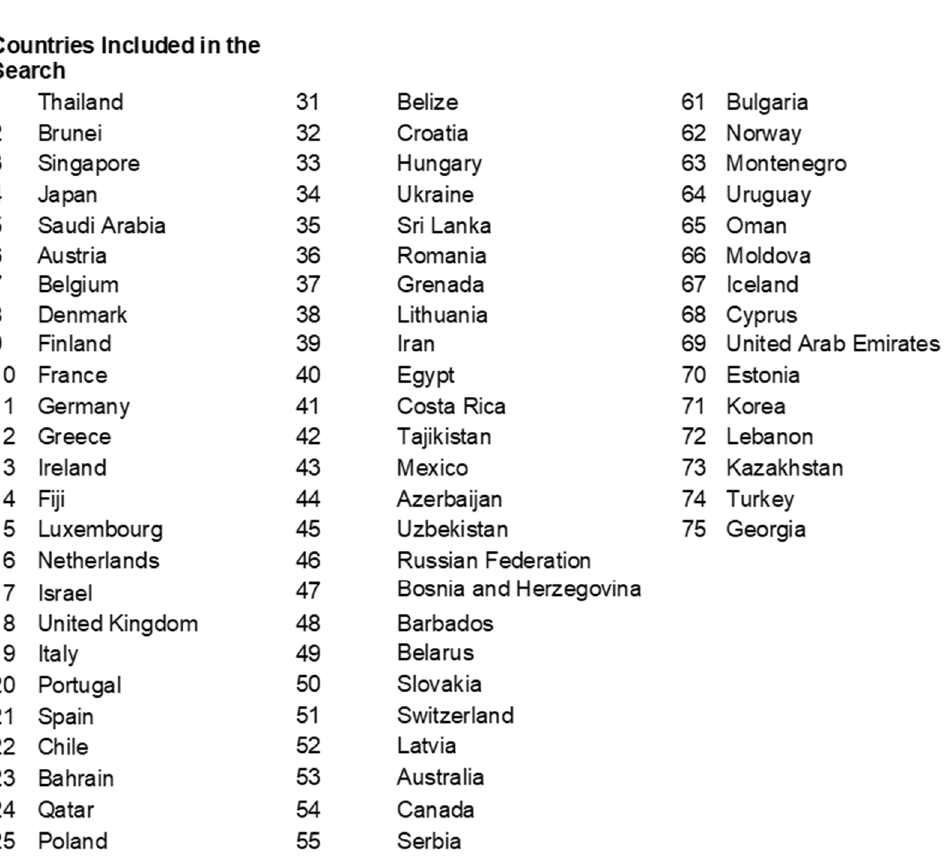
Figure A1. List of countries included in the study.